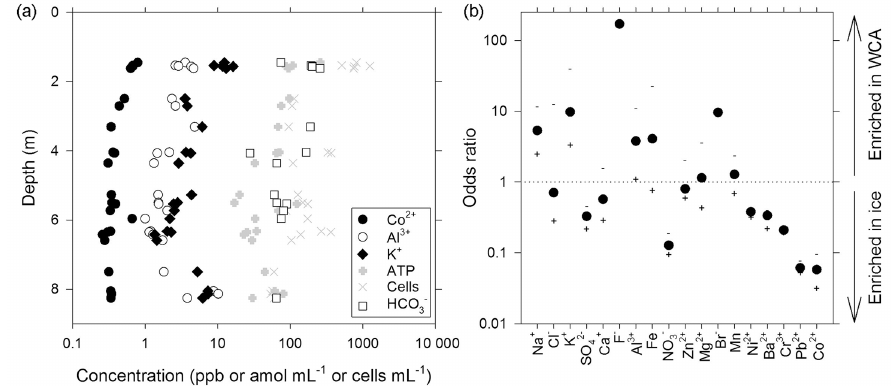
Figure 3. Geochemical composition of melted ice and water from the WCA. (a) Depth profile for analytes correlated with the cell and/or ATP data. (b) Ratio of compounds in the WCA water samples relative to the average in ice from depths of 1.4 to 11.3m. The order of compounds is based on their abundance in the WCA sample (i.e., decreasing abundance from left to right). The plus and minus symbols are the ratios based on the maximum and minimum values, respectively, observed in the ice profile.